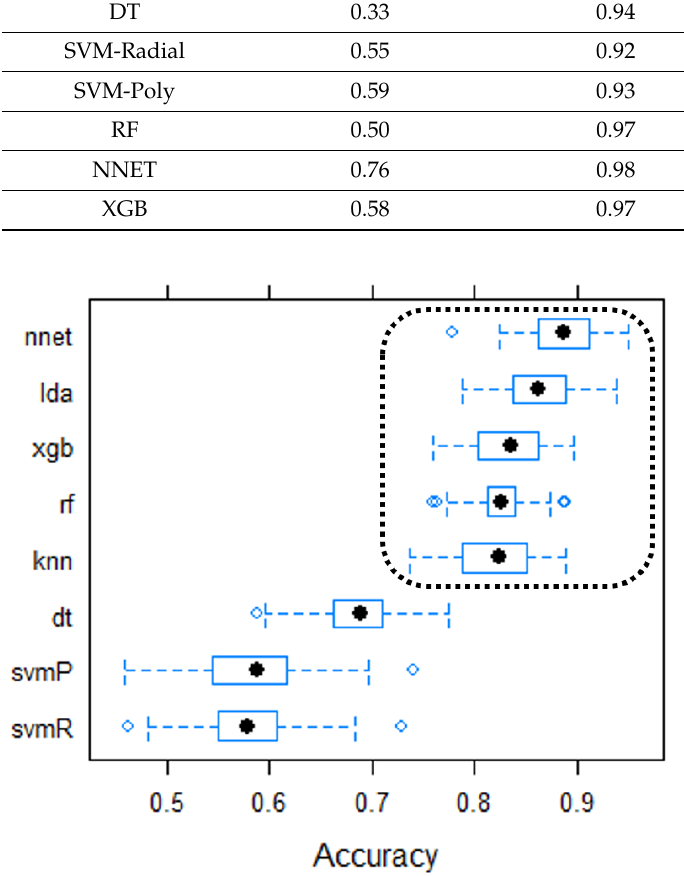
Figure 11. Layer-1 Training Performance Comparison (4-Bus System). Table 3. Layer-1 Models Performance (4-Bus System).